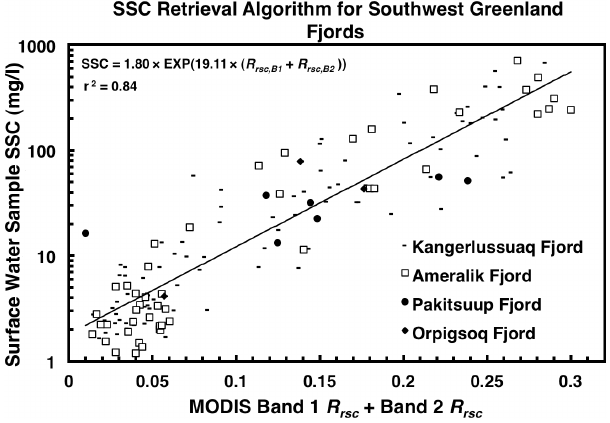
Figure 4. Relationship between MODIS band one and two cor- rected remote-sensing reflectance ( R rsc ) and surface water sample SSC values used in retrieval